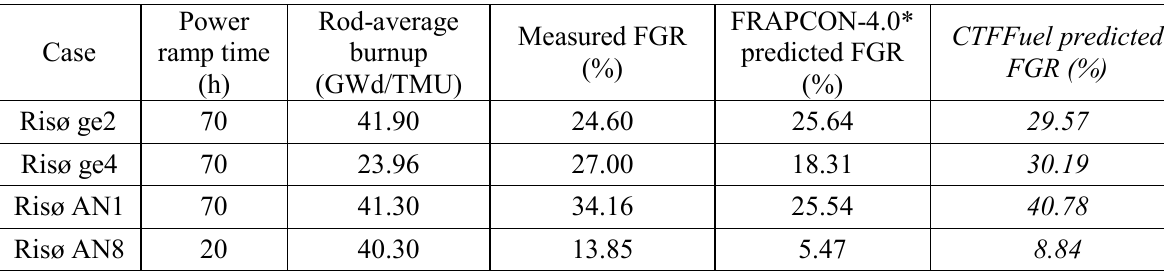
Table II: Power-ramp FGR V&V